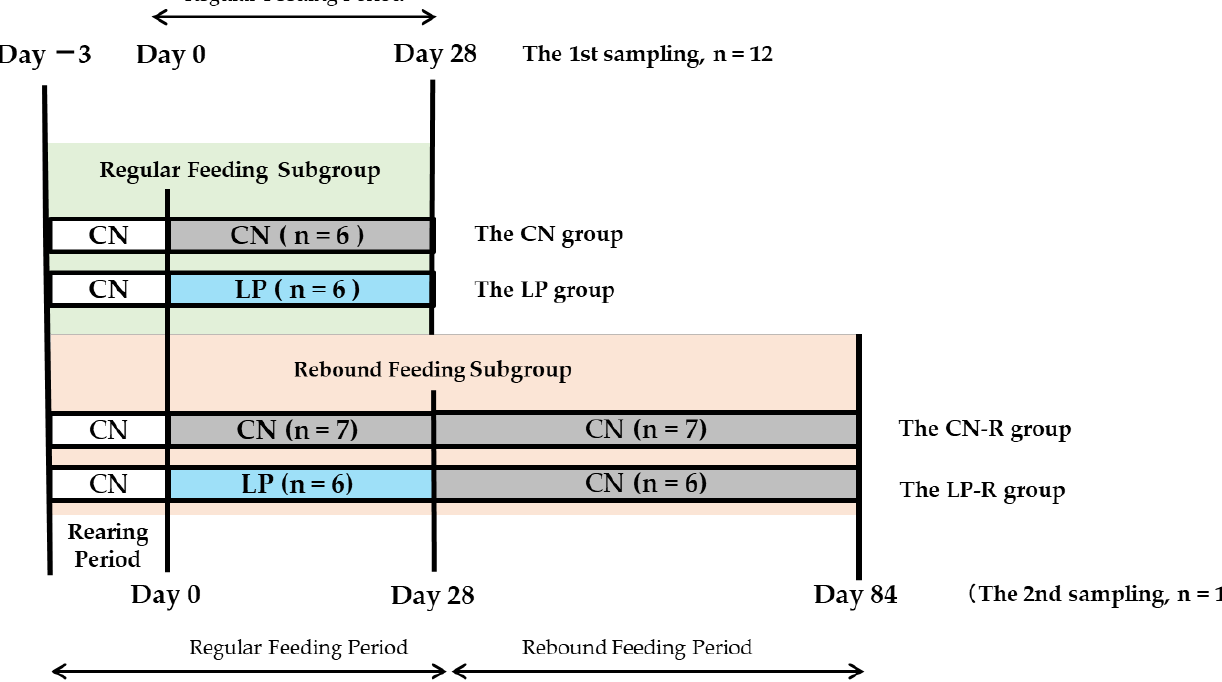
Figure 3. Study design. CN: control diet; LP: low-protein diet. CN-R, CN followed by rebound feeding. LP-R, LP followed by rebound feeding.